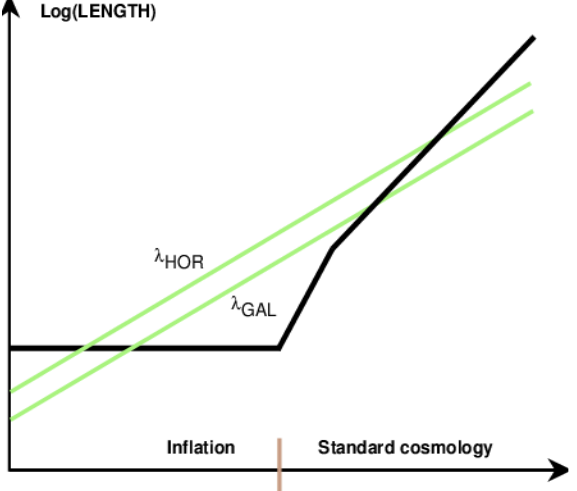
Figure 1. Comparison between evolution of Hubble radius and cosmological scales in inflation. The green straight lines are the perturbation scales; the black solid line is the Hubble radius. The horizontal axis depicts log ( a ) .